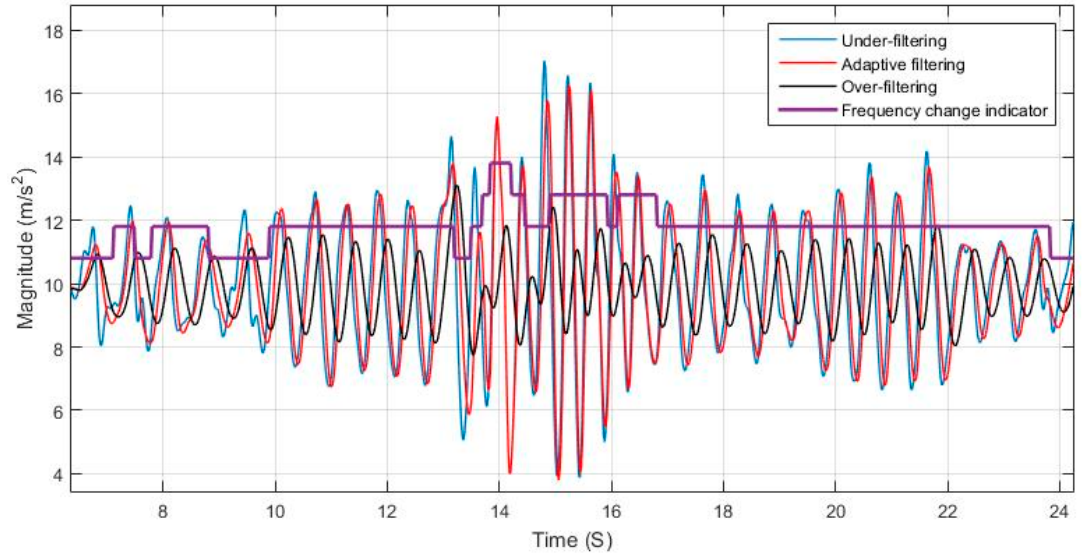
Figure 7. Adaptive filter comparison to constant cut-off frequency for changing walking speed.